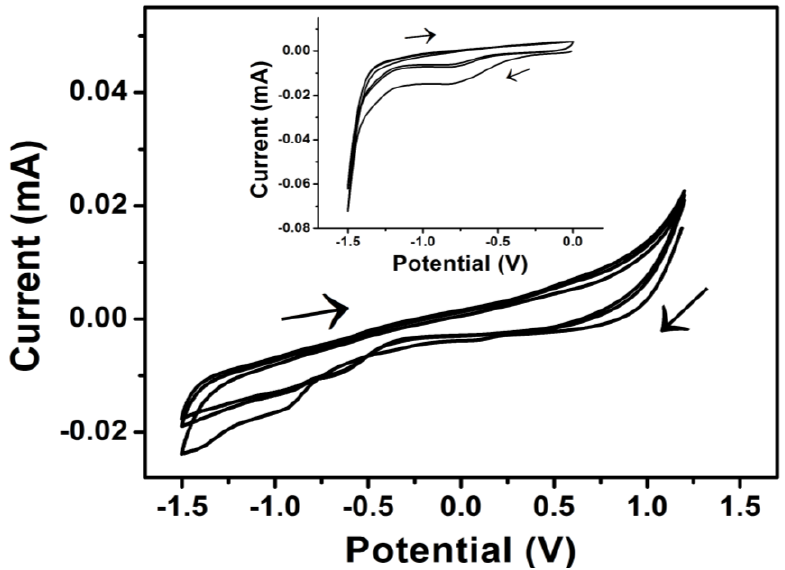
Figure 1. CV of 0.01 mg/mL GO and 0.01 M EDOT on GCE electrode (Scan rate: 0.1 V/s). Inset: CV of GO reduction on GCE at potential 0 to −1.5 V (Scan rate: 0.1 V/s).